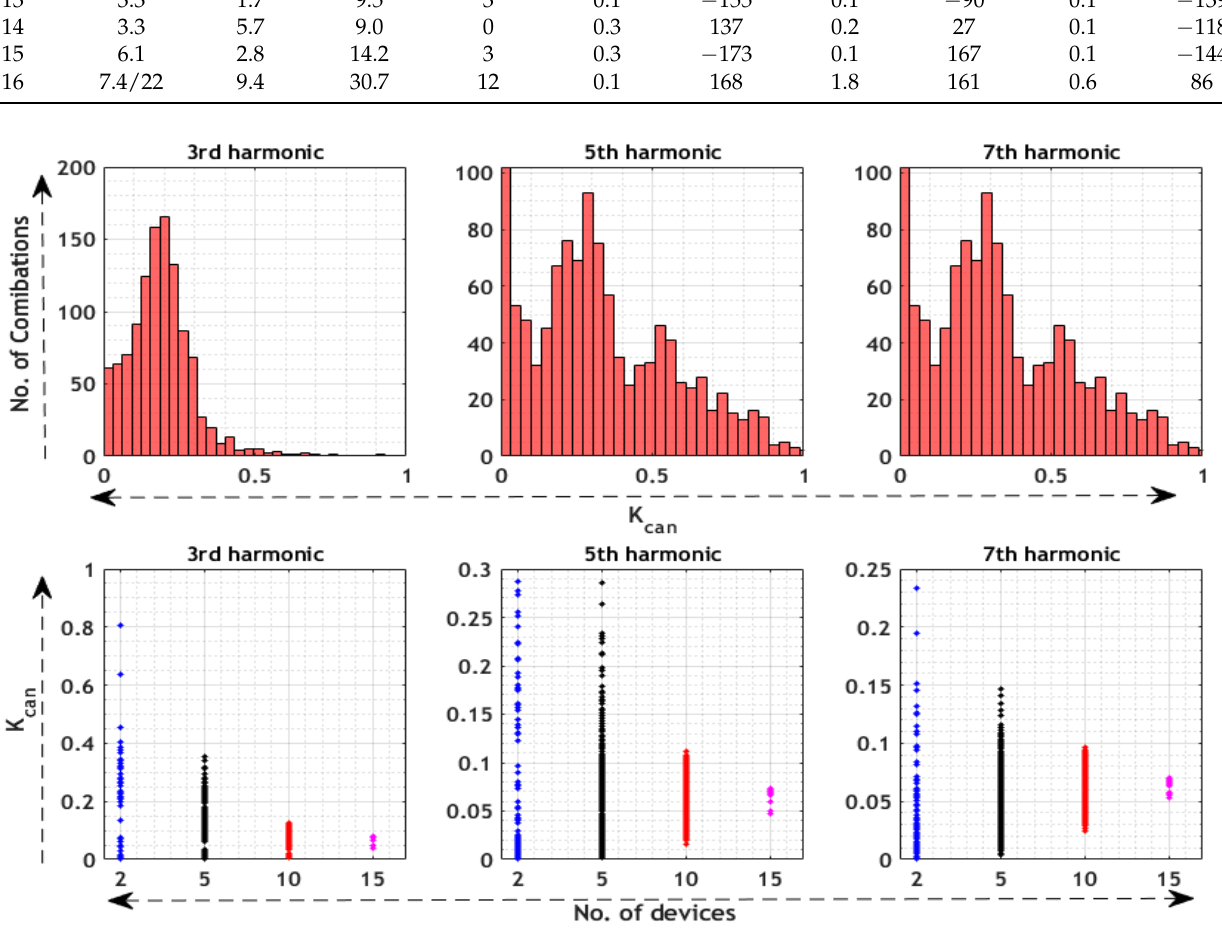
Figure 10. Harmonic cancellation effect of EV loads. Table 3. Measured harmonics for individual EVs.